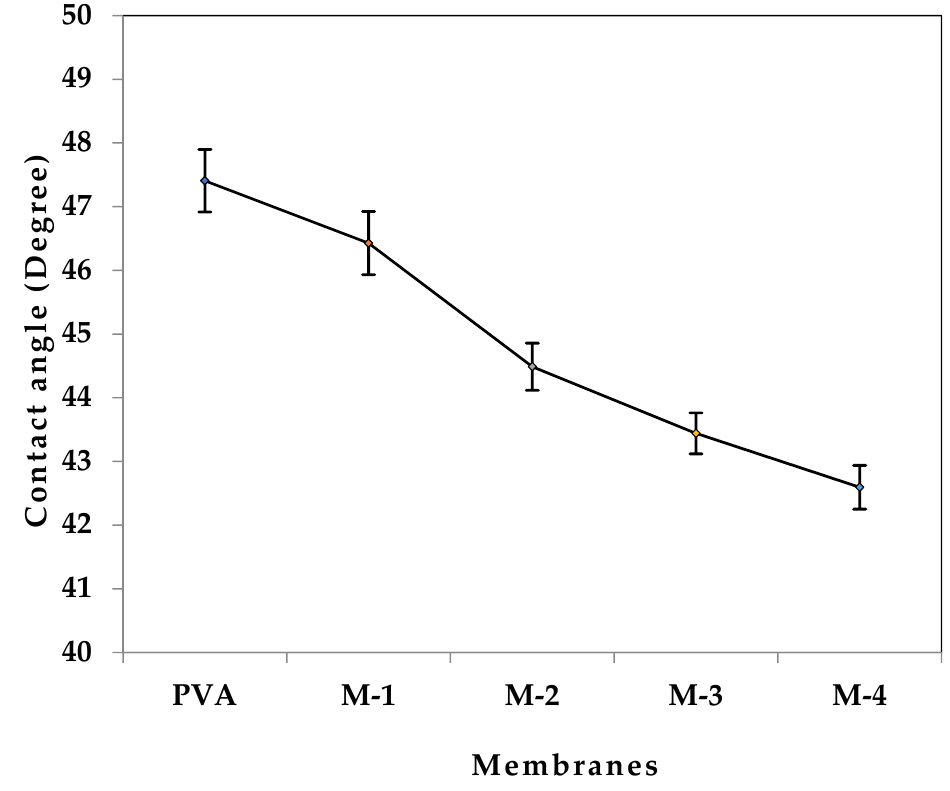
Figure 6. Contact angles of water for all the membranes at 10 s.